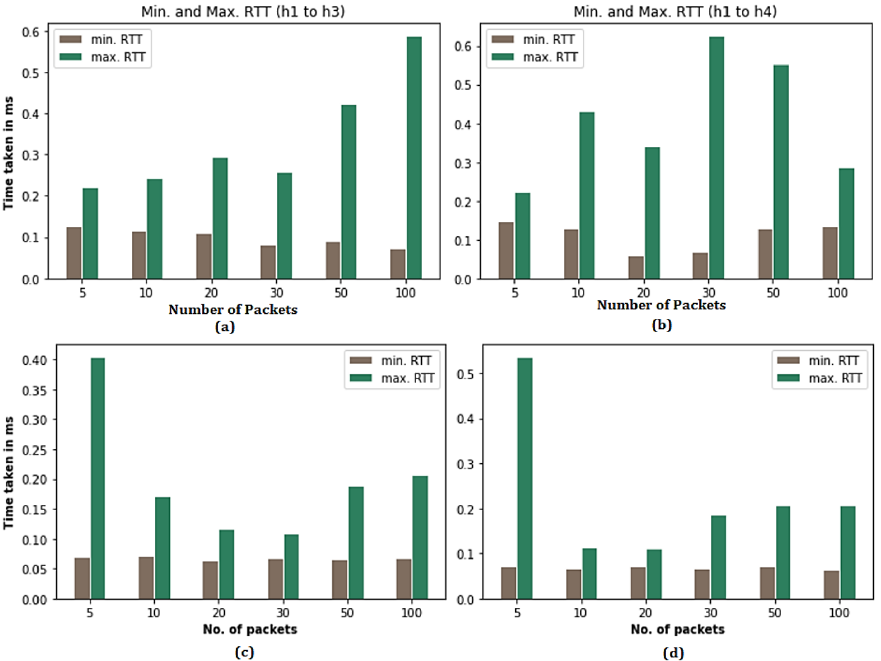
Figure 18. Min. and Max.RTT for neighbouring AS for Host h1, ( a , b ) in Legacy, and ( c , d ) in SDN.